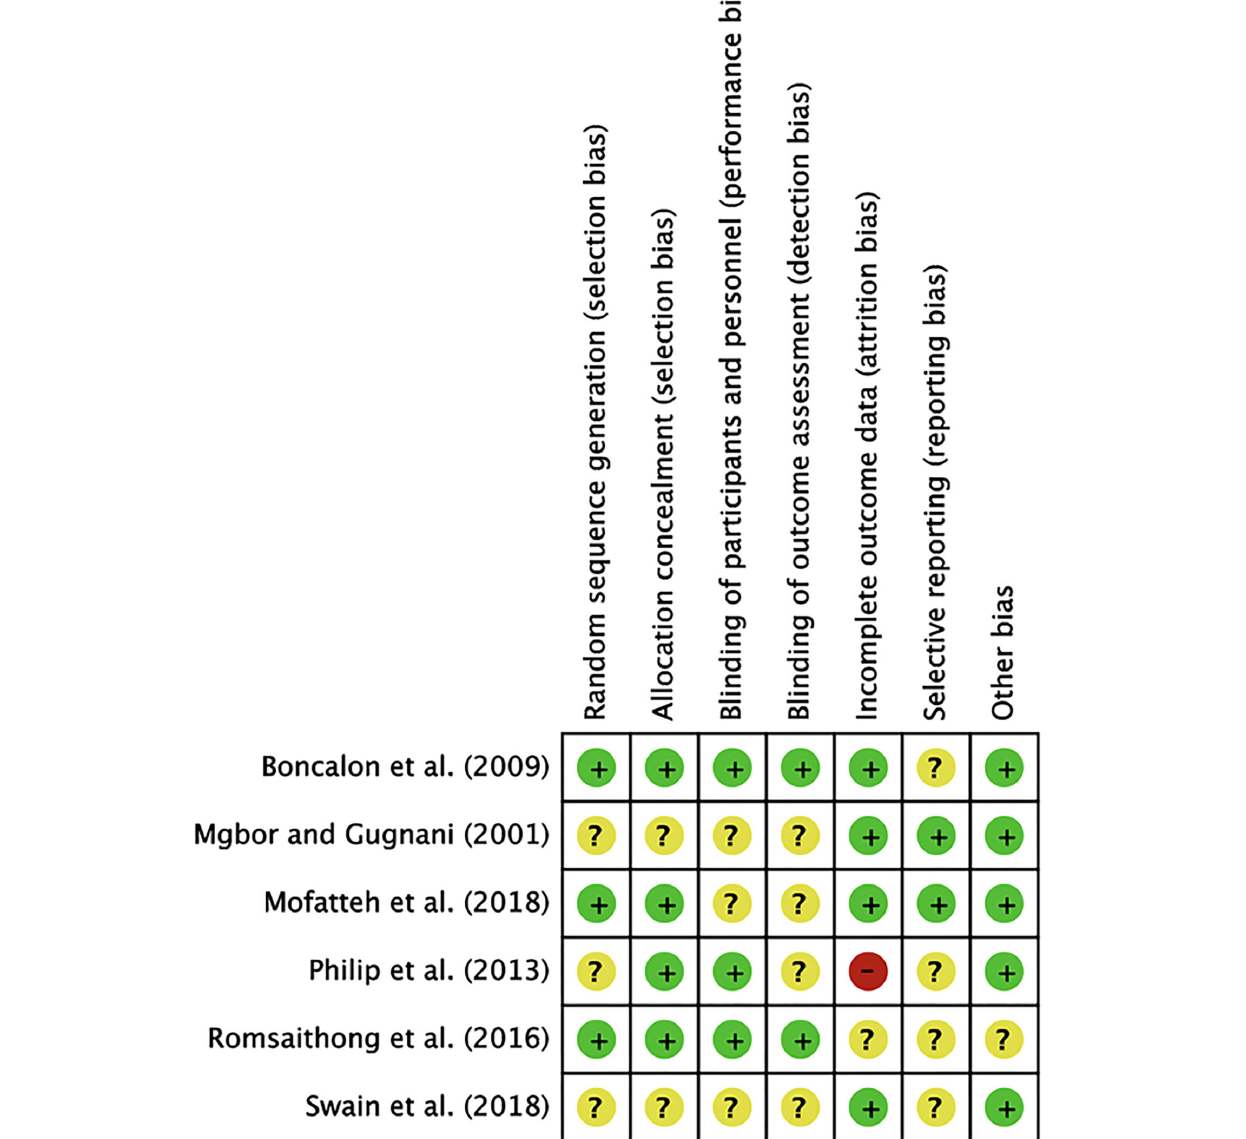
Frontiers in Surgery |